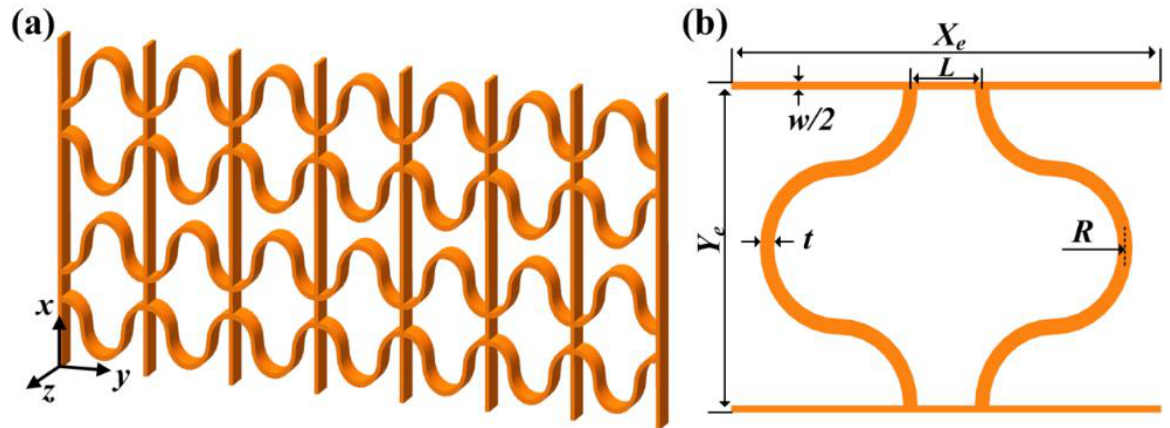
Figure 1. ( a ) A 3D model of active SMA honeycomb array; ( b ) geometric parameters.